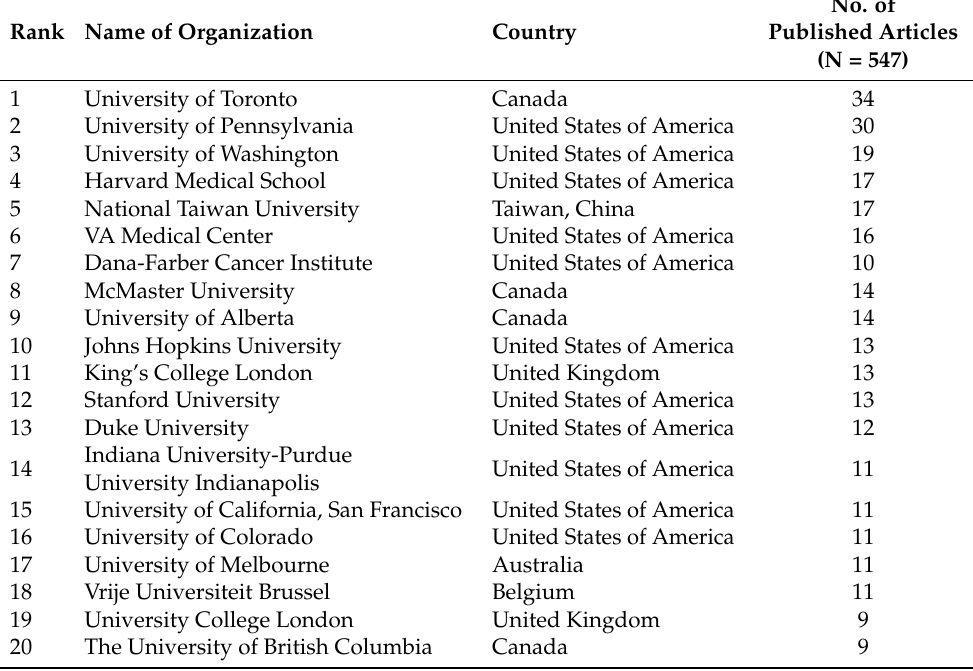
Table 2. Top Organizations with the highest relevant publications on